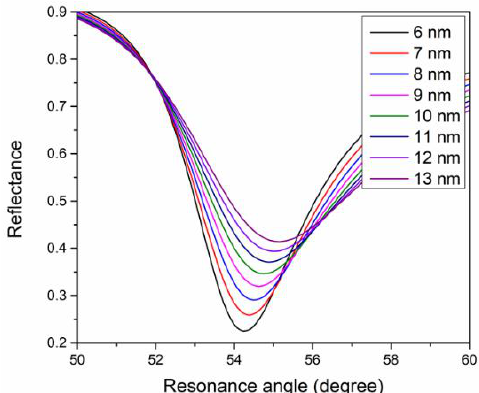
Figure 11. Optimization of the SPR signal based on different thickness of NCC-based layer.